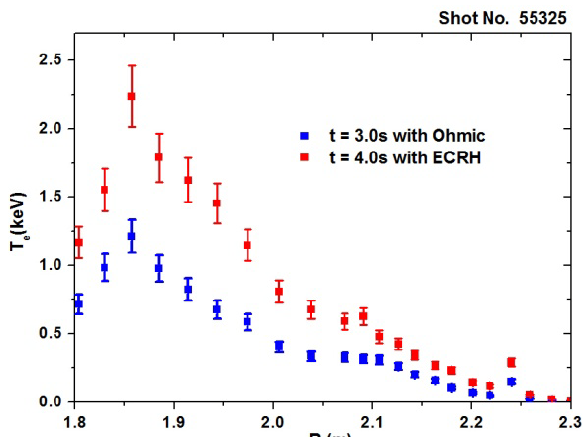
Fig. 12. Effect of ECRH on the electron temperature (T e ).